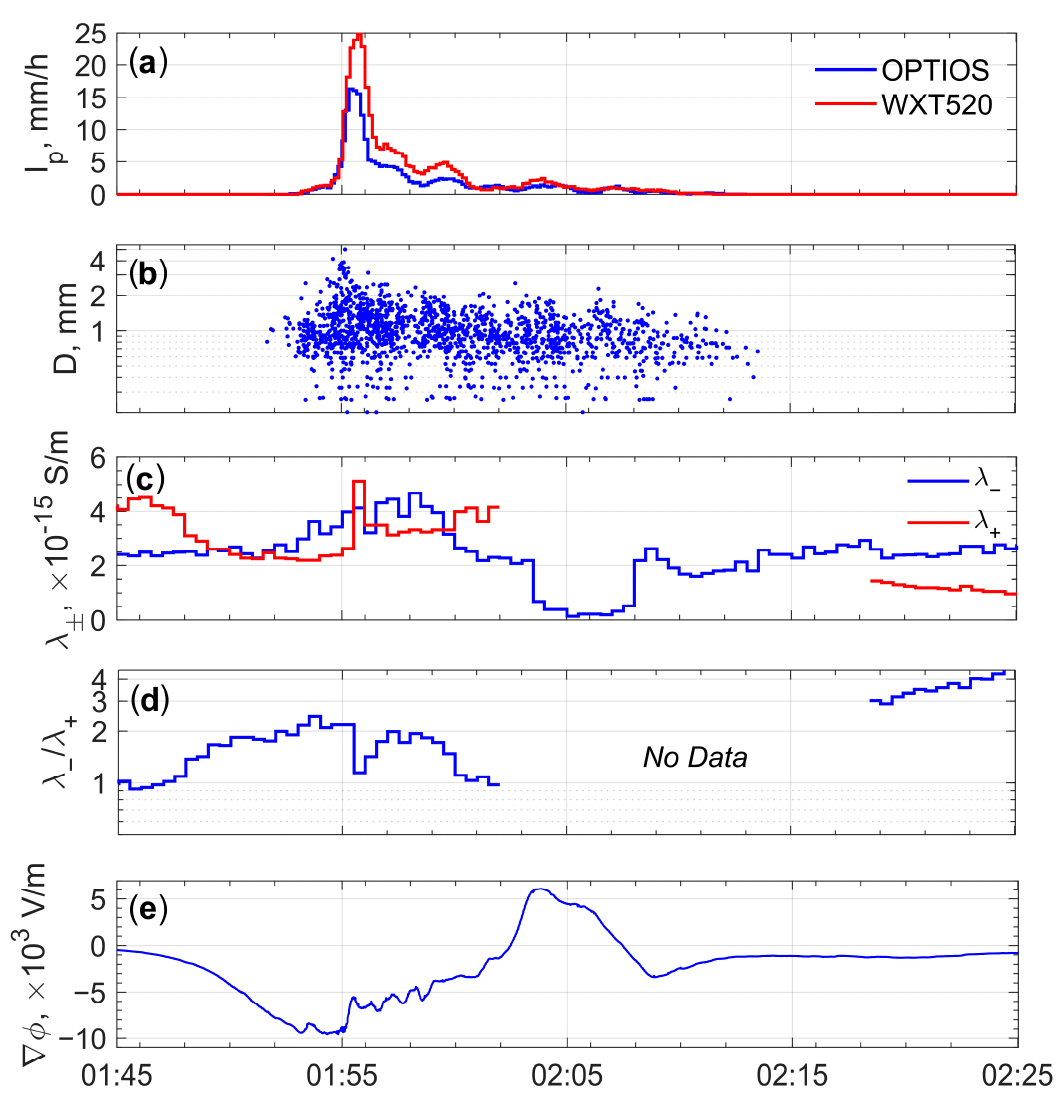
Figure 4. Pattern of atmospheric electric values and intra-mass precipitation characteristics for 23 June 2019. The plots (from up to down) show the variation of precipitation intensity I p ( a ), droplet density written in time–droplet diameter coordinates D ( b ), electroconductivity λ − , λ + ( c ), electroconductivity ratio λ − / λ + ( d ) and potential gradient ( ∇ ϕ ), recalculated based on the conversion factor ( e ). Here is shown a local time.